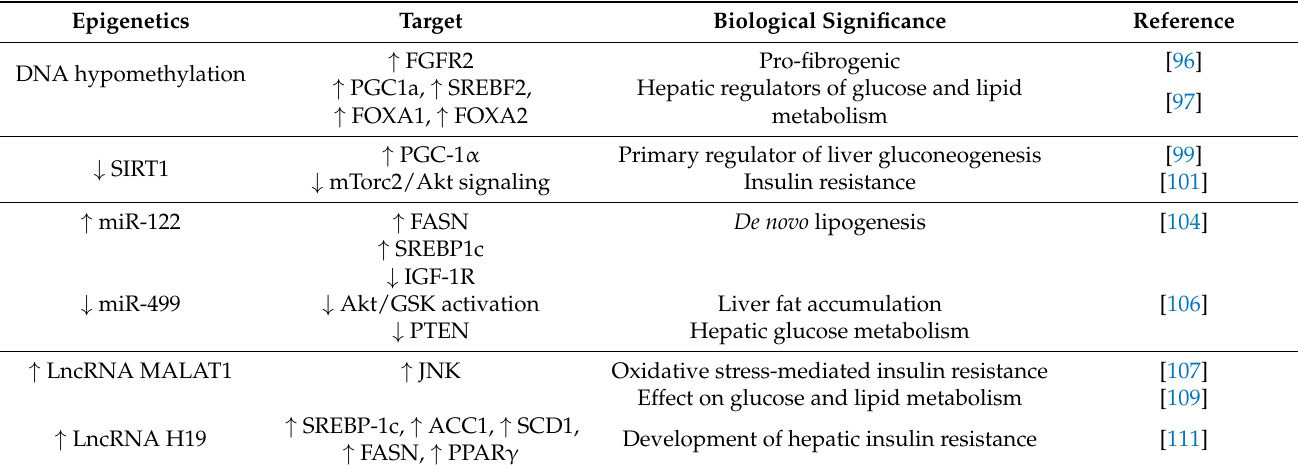
Table 2. Epigenetics mechanisms involved in NAFLD pathogenesis and